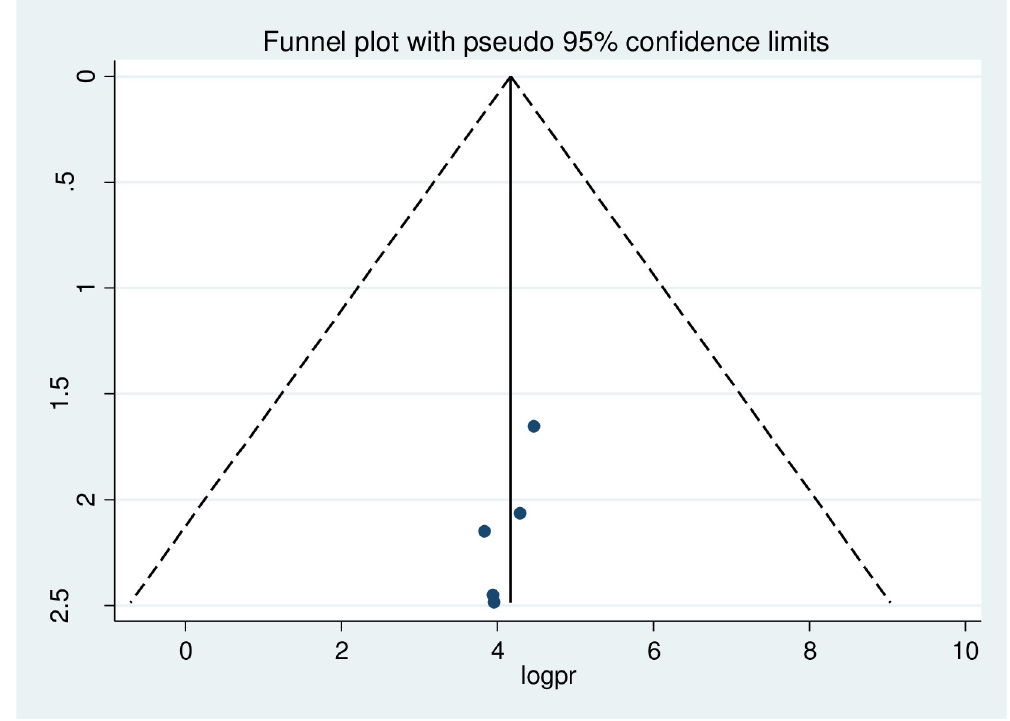
Fig 7. Assessment of publication bias for practice of pregnant women’s towards COVID-19 infection prevention.